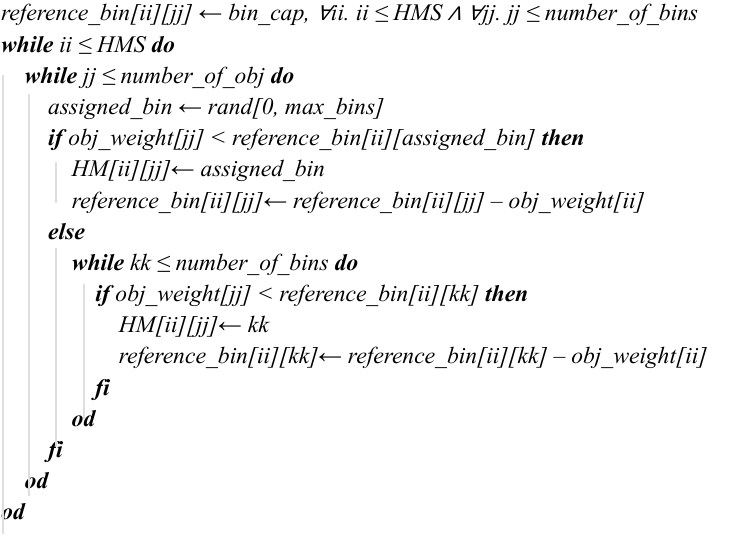
Fig. 3. Pseudocode for harmony memory initialization procedure